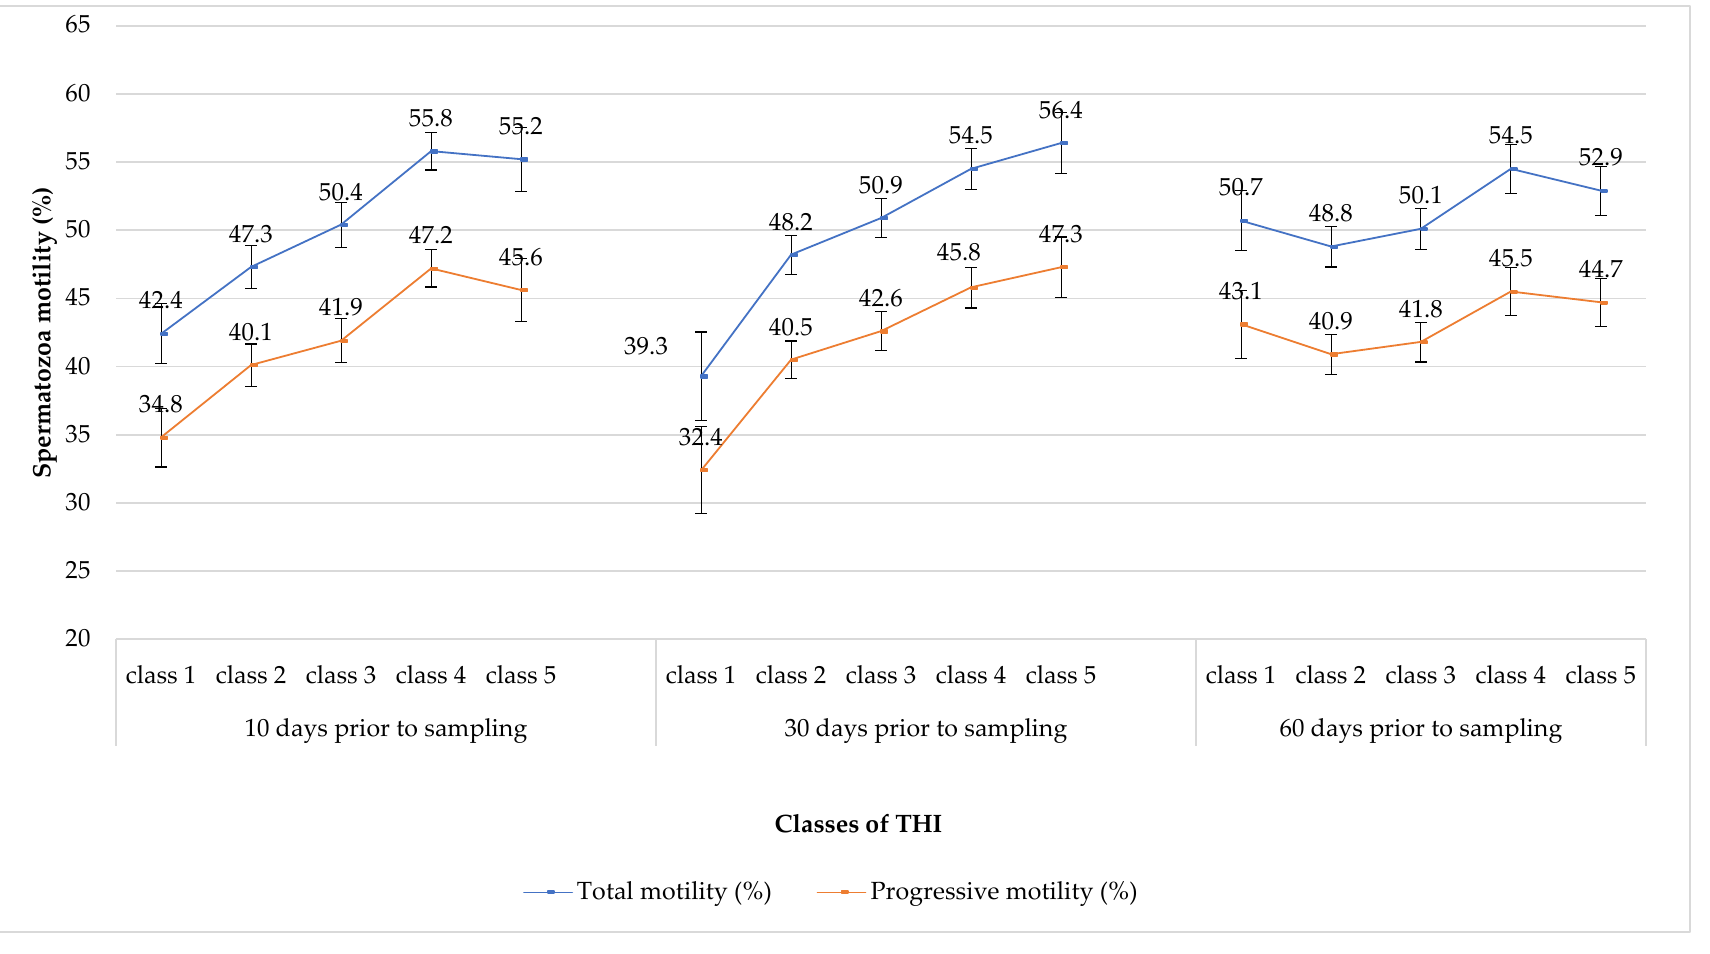
Figure 3. Trends of spermatozoa motility (both total and progressive) corrected means through the five increasing classes of THI for the three periods of spermatogenesis considered.